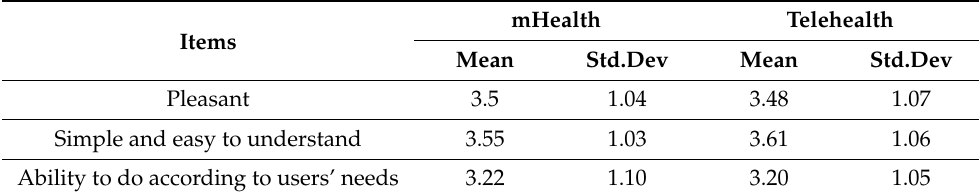
Table 6. Interface quality of mHealth and Telehealth.